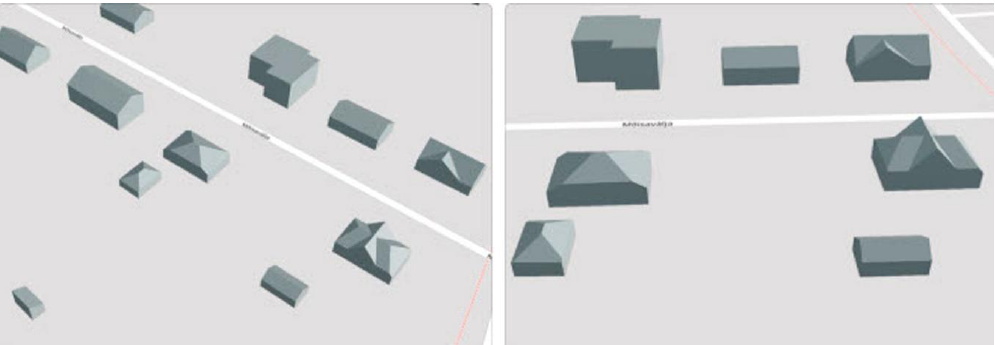
Figure 5. Visualization of flat, gable, and pitched roofs that belong to a set of LPM-building models generated for an urban area of Tartu-city, Estonia. The visual is presented from the ELiT Server web- interface. A free global map, Open Street Map (OSM) as a global world map, is used as a ground- basis.